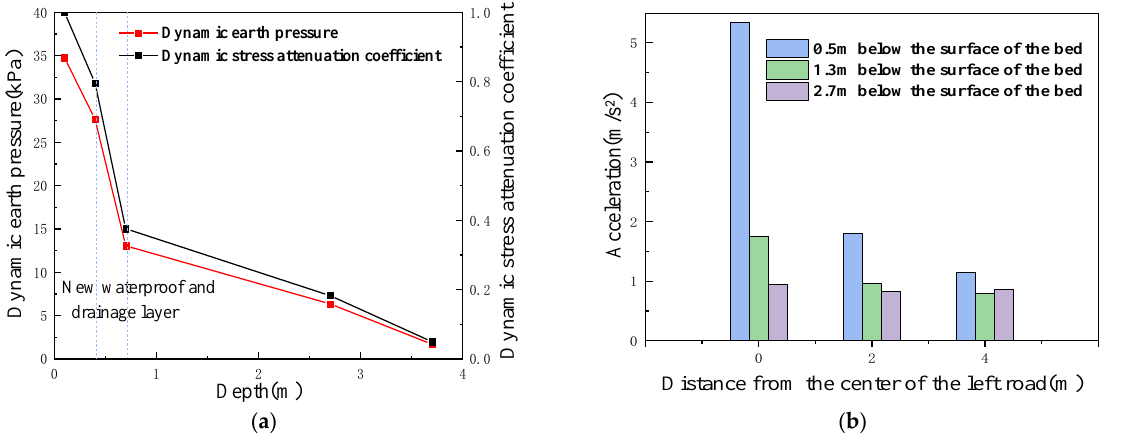
Figure 13. Analysis of dynamic stress test results: ( a ) variation law of dynamic stress with depth; and ( b ) distribution law of dynamic stress along the transverse direction.